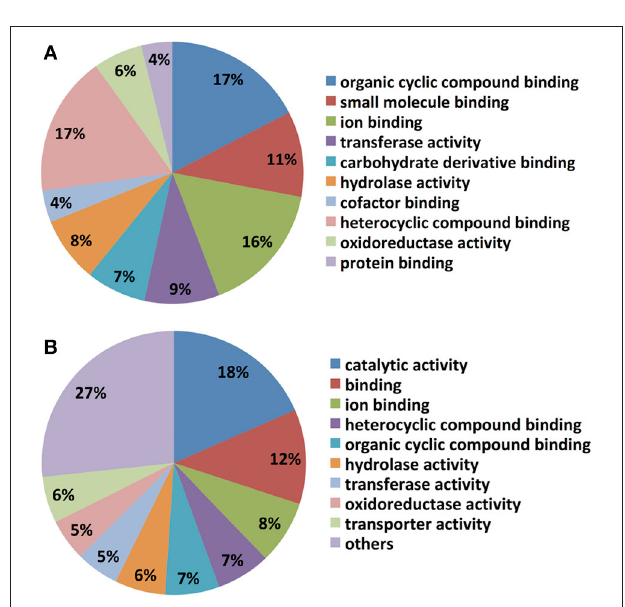
FIGURE 4 | Molecular level classification of up-regulated hits in the AMC941 unigene library. Up-regulated gene hits were evaluated by BlasttoGO, and molecular level classification assignments relative to MeOH treated C. rosea , obtained for (A) C. rosea treated with 5 ppm DON and (B) C. rosea treated with Fusarium- spent media (containing live macroconidias), both relative to MeOH treated C. rosea